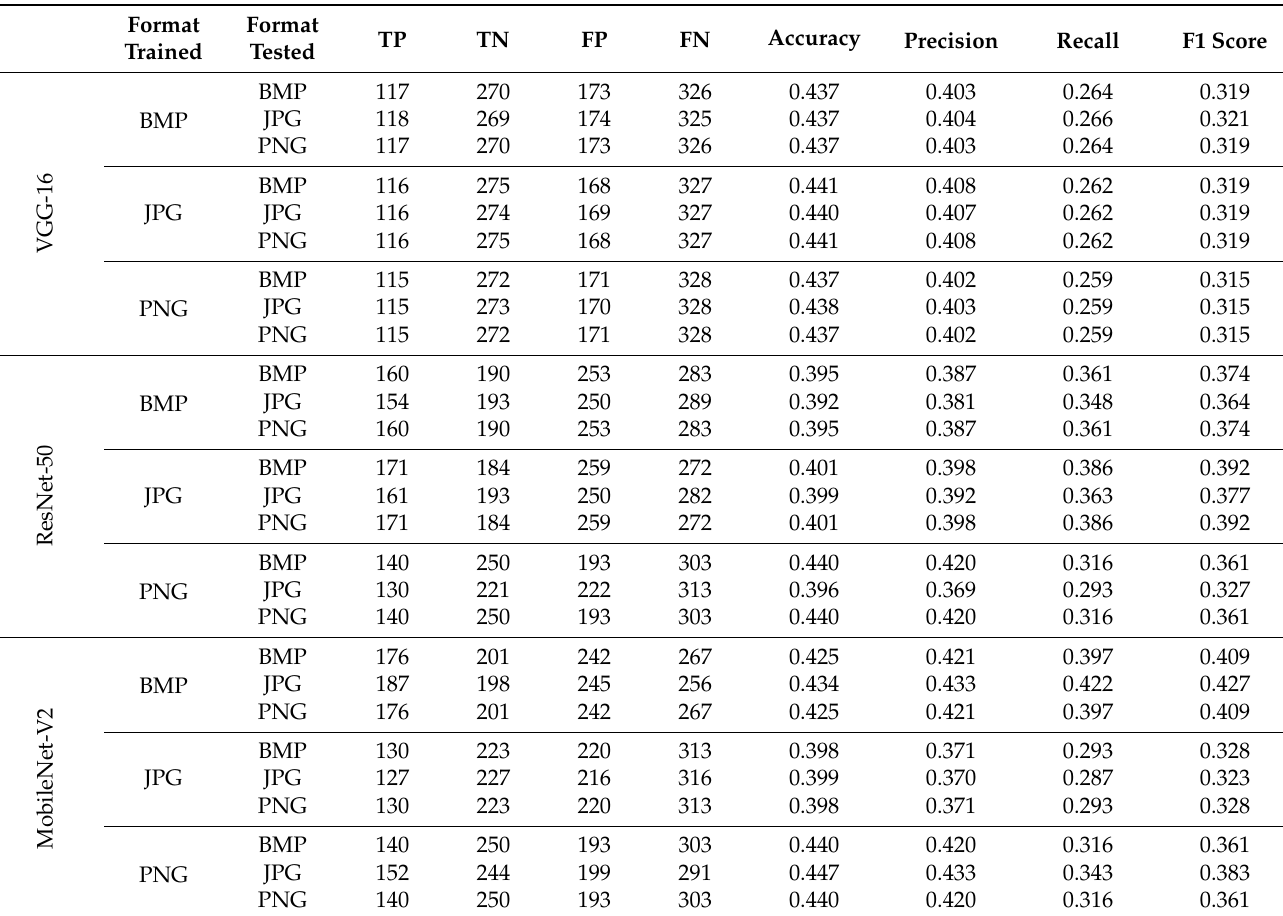
Table 5. Experimental results of large dataset trained 400 epochs models when evaluated by common file